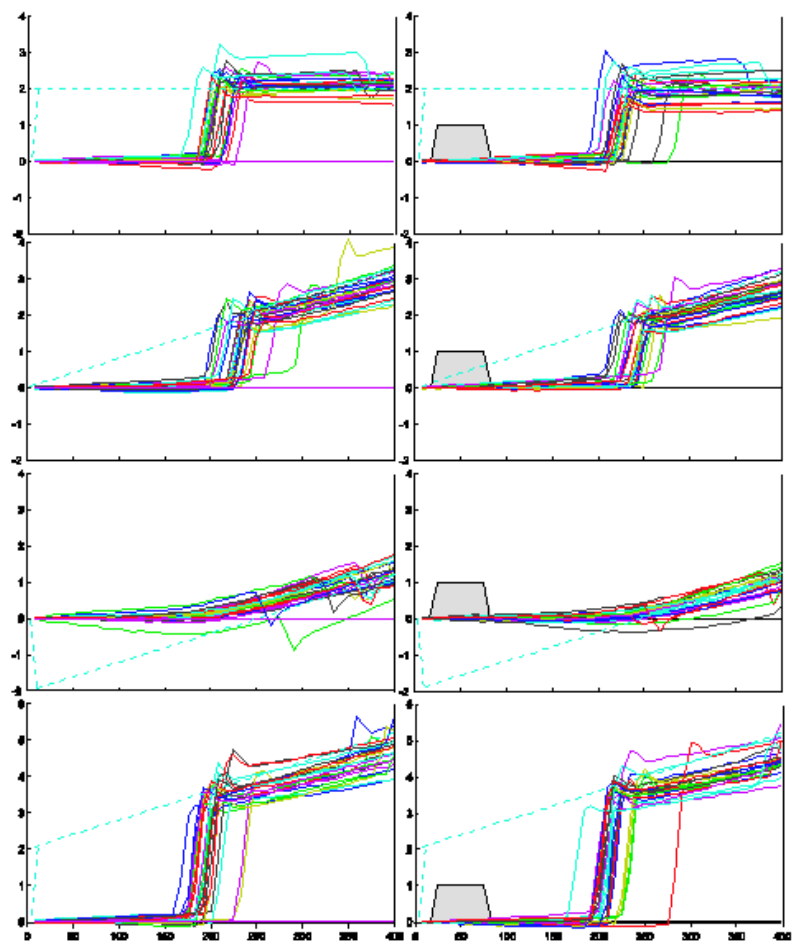
Figure 2 : Raw eye movement traces for subject PMC, 8 of the 45 conditions. The dashed line plots target position; the gray box shows gap